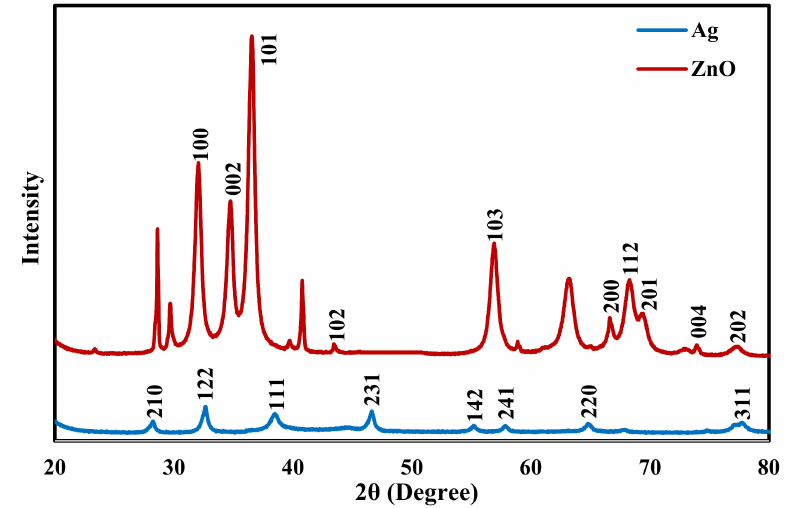
Figure 4. XRD pattern of AgNPs and